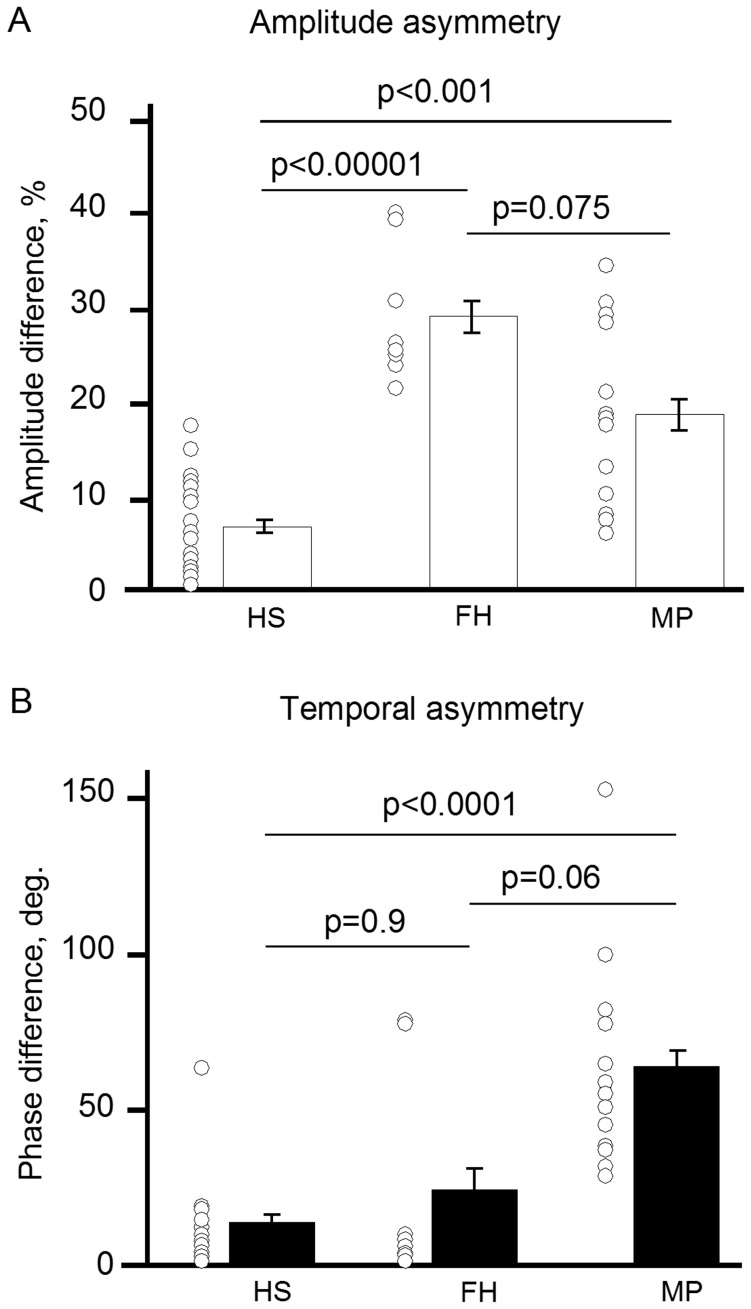
Distribution of the side-to-side difference in blood pulsation parameters among groups of migraine patients (MP) and healthy subjects with (FH) and without (HS) family history of migraine.Bars: mean values with SDs, circles: individual values. A, the amplitude difference, B, the phase difference.